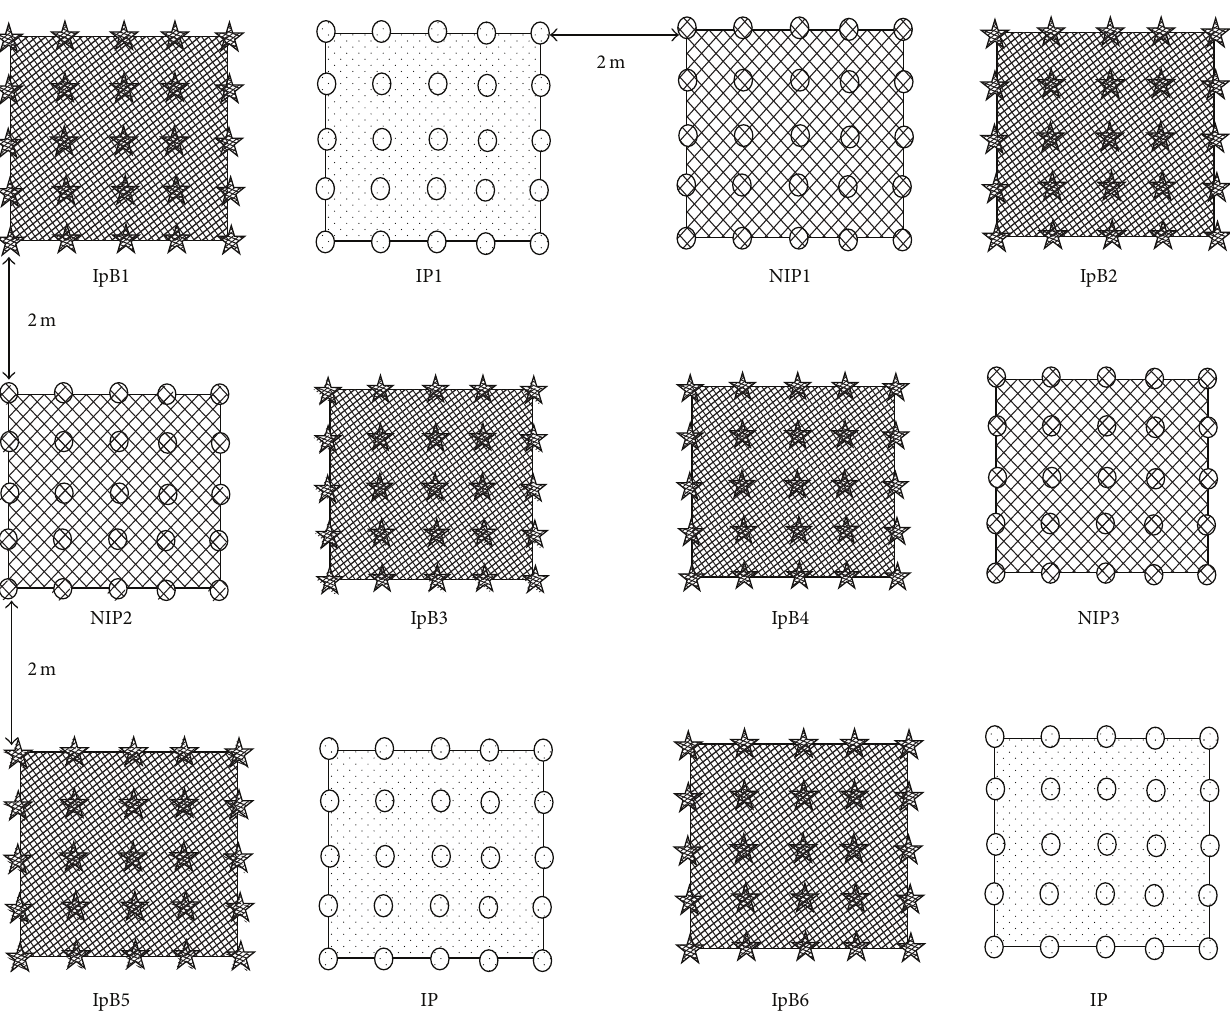
Figure 1: Experimental design. IP = inoculated Pueraria , NIP = noninoculated Pueraria , and IpB = Ipomoea batatas . IP and NIP treatments were each replicated 3 times, giving a total of 6 Pueraria plots. Ipomoea plots (six) were interspersed in each Pueraria plot as non-N 2 -fixing references. Plot’s size was 4 m 2 . In each plot, plant spacing was 50 cm corresponding to 9 hills per 1.5 m × 1.5 m for both Pueraria and Ipomoea . For Pueraria , seeds were sown but thinned to 3 plants per hill after the seedlings were well established while, for Ipomoea , uniform seedlings of 10 cm length were transplanted two weeks after the sowing of Pueraria seeds. Pueraria inoculation was performed using the effective strain B. yuanmingense S3-4 (2.094 × 10 8 cells per hill) three weeks after seed’s sowing. All plots received 2gN/m 2 of 15 N labelled ammonium sulfate 10% atom excess applied at 1 and a half months after Pueraria seeds were sown. Plots were regularly weeded throughout the rain-fed prone experiment that lasted 4